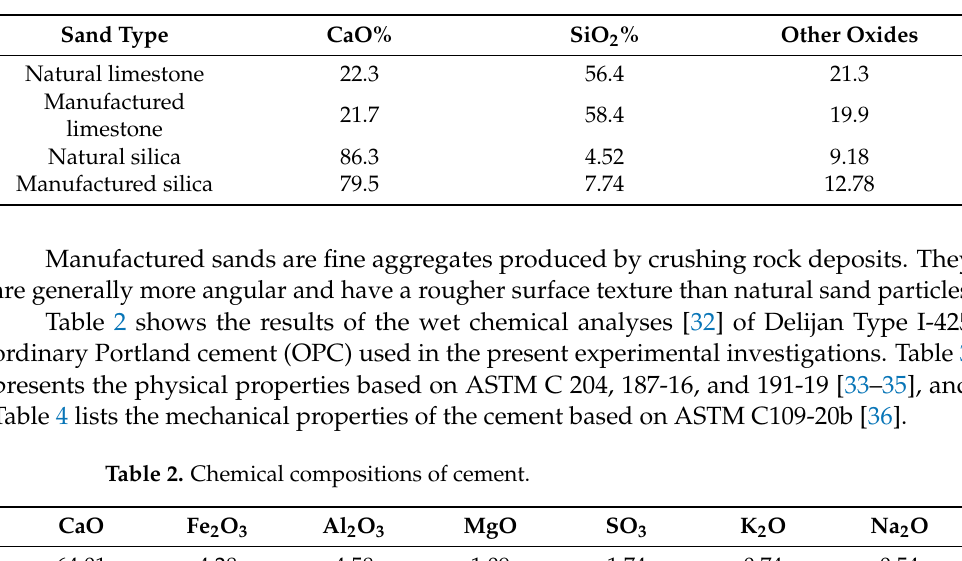
Table 1. Chemical composition of the sand lithology.